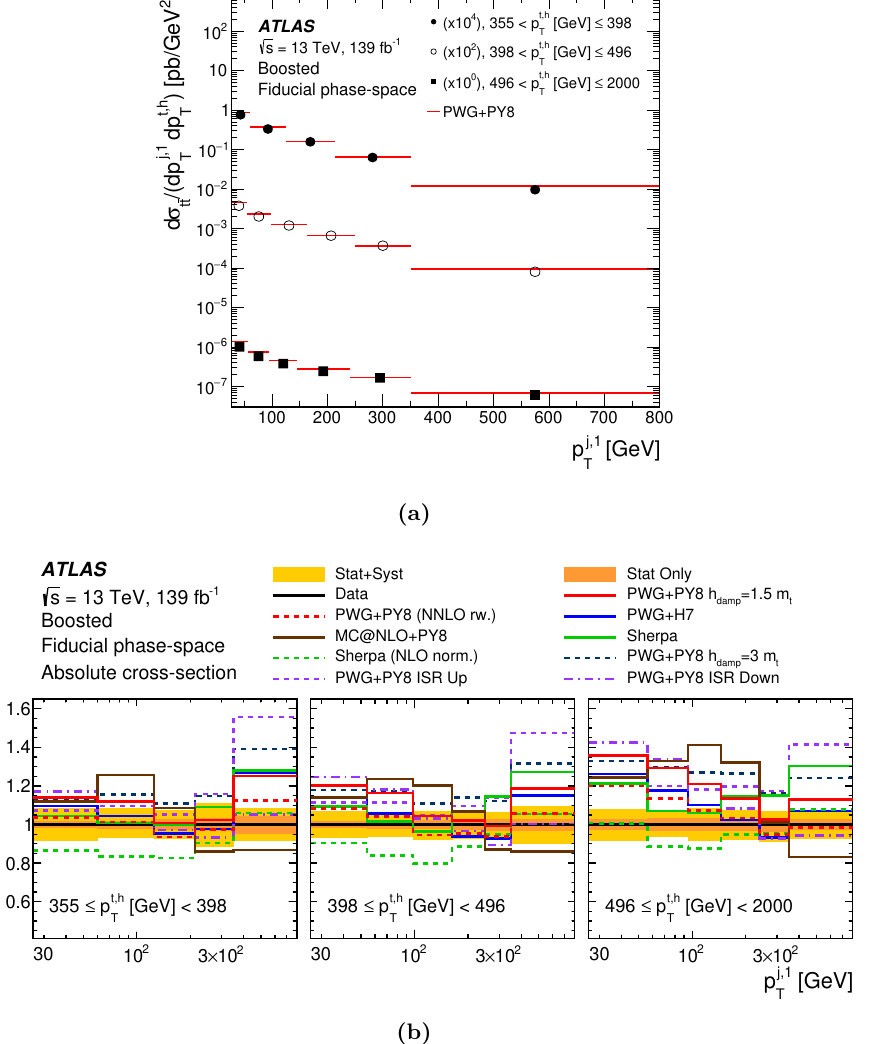
of the leading Figure 15. (a) Differential cross-section measurements as a function of the p T additional jet in bins of p t,h are compared with the prediction from the Powheg+Pythia MC T generator. The measurement and the predictions are normalised by the factors shown in paren- theses to aid visibility. (b) Ratio of the measured absolute cross-section to different NLO, and NLO reweighted to NNLO, predictions of t ¯ t signal for the same differential variables. PWG+PY8 corresponds to the Powheg+Pythia sample, PWG+H7 to the Powheg+Herwig sample and MCatNLO+PY8 to the MadGraph5_aMC@NLO+Pythia sample. The yellow band represents the total uncertainty of the measured differential cross-section while the orange band shows the statistical